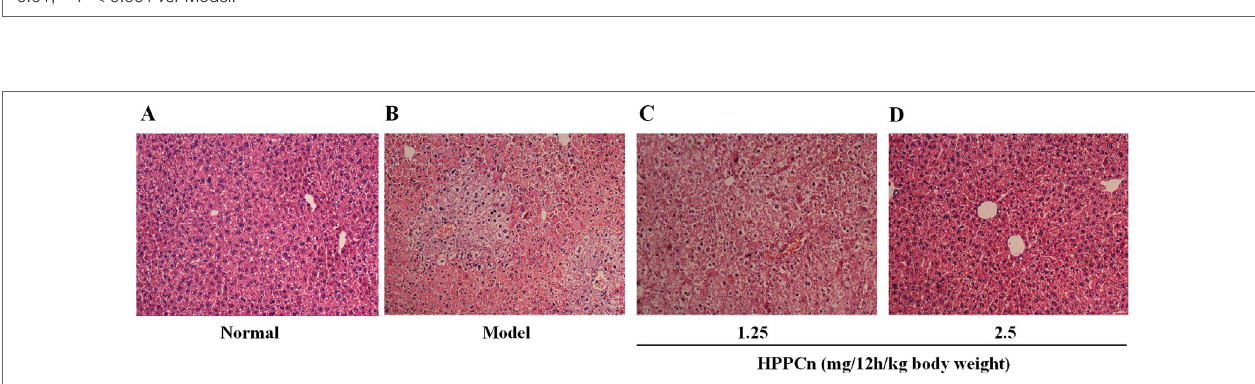
FIGURE 5 | The effects of rhHPPCn on the serum levels of GOT and GPT in CCl 4 -induced acute liver injury model mice. (A and C) The serum levels of GOT and GPT in CCl 4 -induced acute liver injury model mice treated with different concentrations of rhHPPCn for 24 were evaluated by ELISA kits. (B and D) The serum levels of GOT and GPT in CCl 4 -induced acute liver injury model mice treated with rhHPPCn for different time periods. The results showed that rhHPPCn could decrease the levels of GOT and GPT in the serum of acute liver injury model mice in a concentration- and time-dependent manner. * P < 0.05 vs. Control; # P < 0.05, ## P < 0.01, ### P < 0.001 vs. Model.